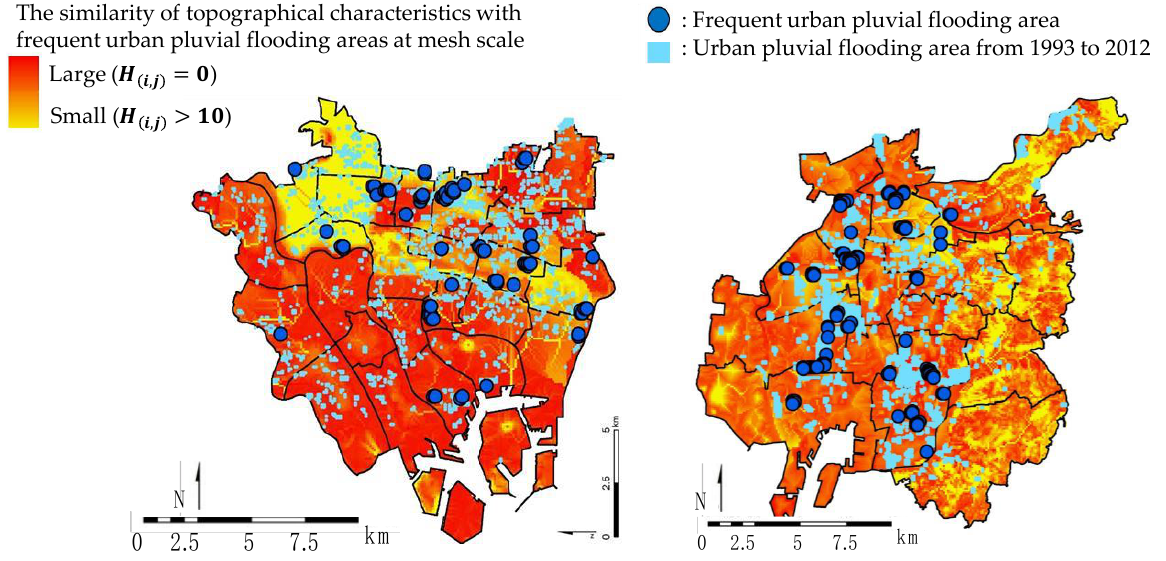
Figure 4. The distribution of H ( i , j ) and the urban pluvial flooding areas (light blue dot) in ( a ) Osaka City and ( b ) Nagoya